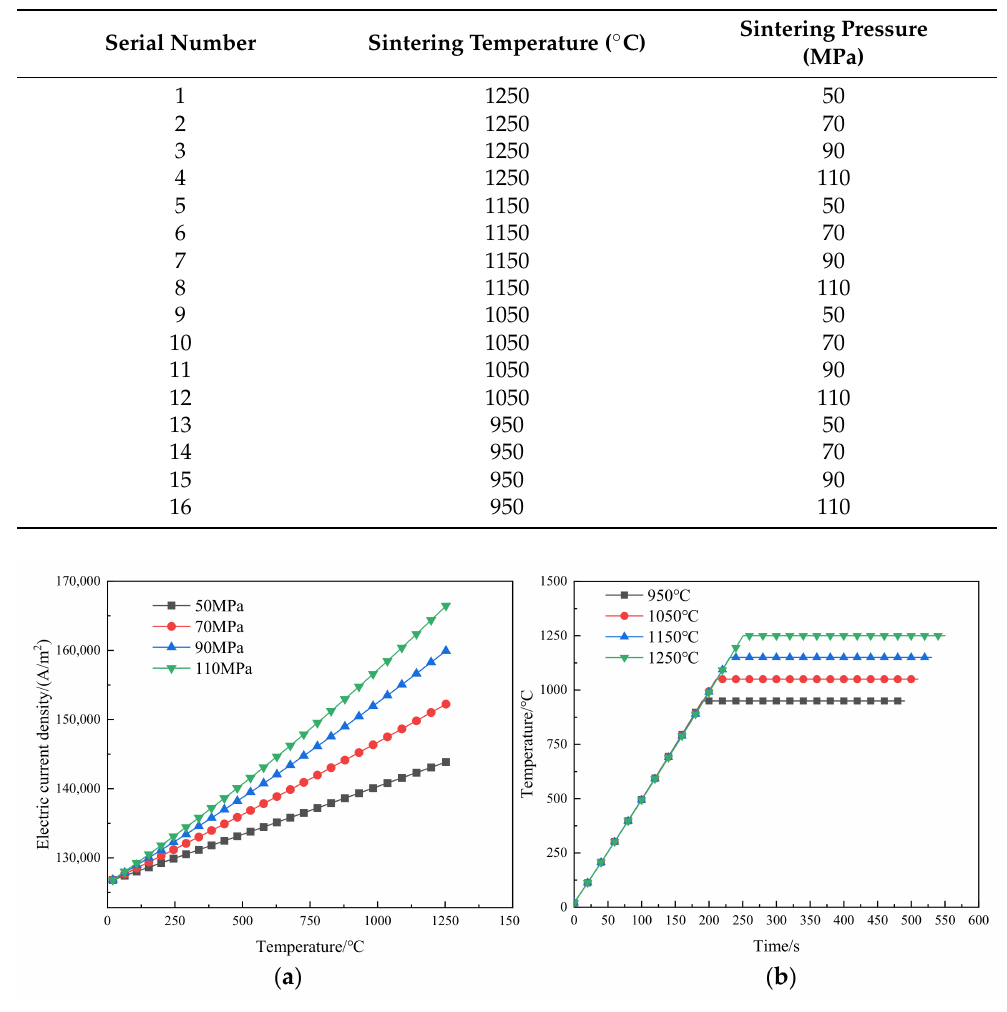
Figure 2. The relationship between electric current density and sintering temperature: ( a ) Setting trajectory of electric current density at each target sintering temperature; ( b ) variation of sintering temperature with